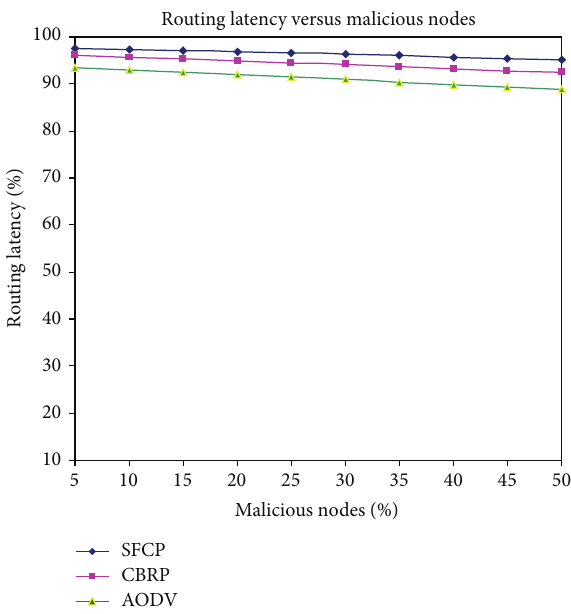
Figure 4: Routing latency versus malicious